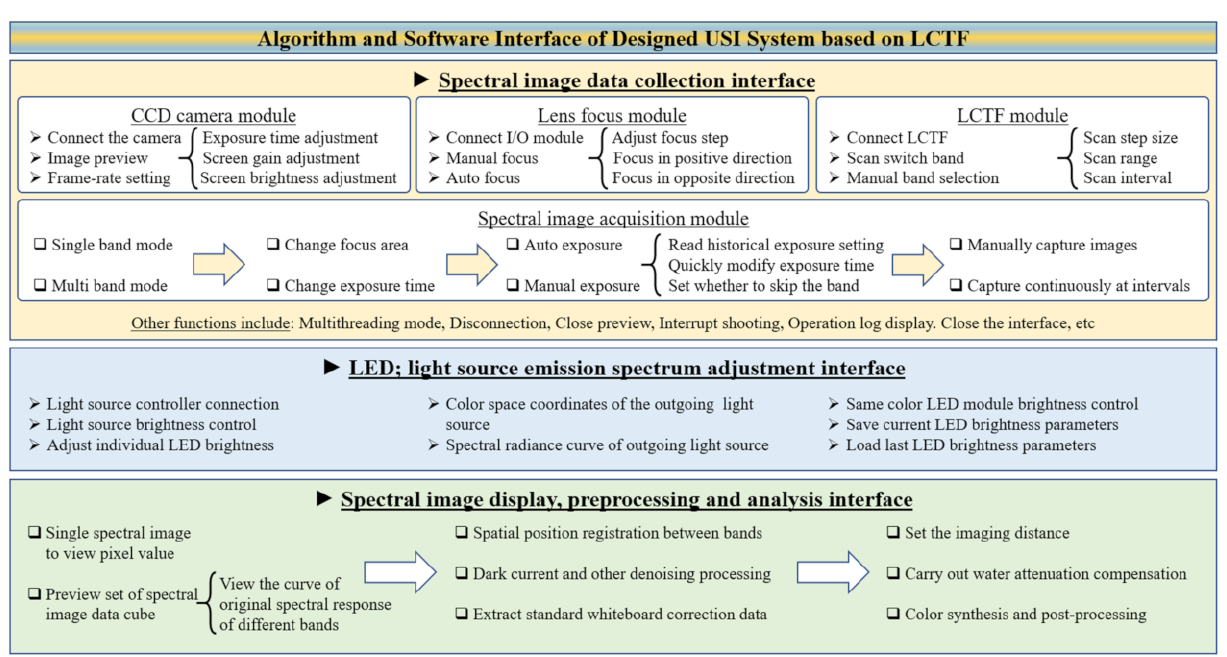
Figure A1. Control algorithm and software structure of USI system and supplementary light source.